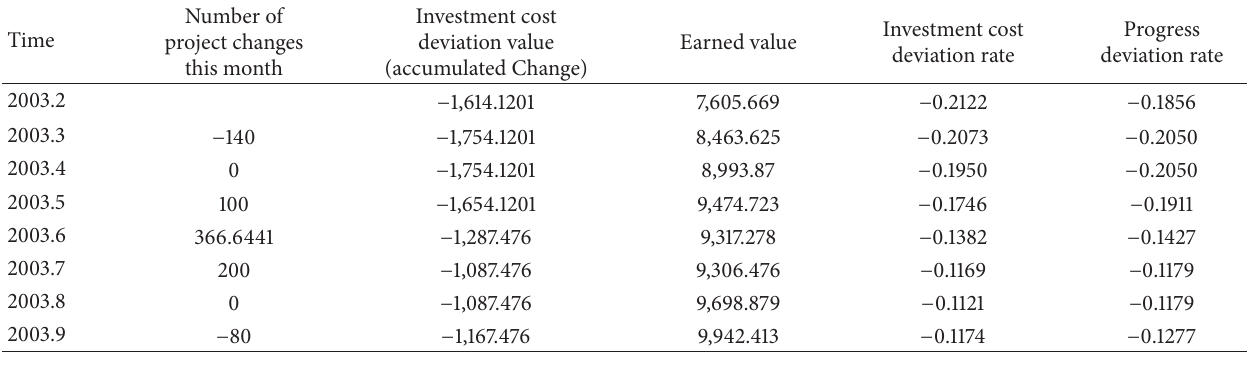
Table 4: Investment cost risk calculations for Contract F 10,000 Yuan.